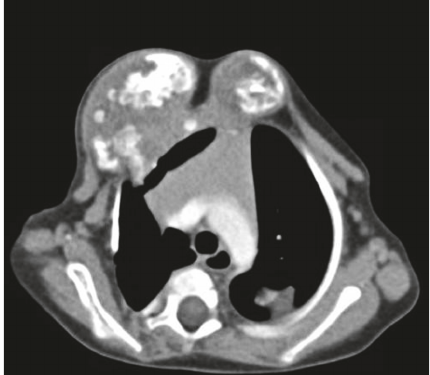
Figure 1: This contrast chest CT scan shows multiple bilateral masses involving mainly the upper ribs, extending into the thorax and causing mediastinal shift to the left. The largest mass measuring 5,7 cm × 4,1cm is located on the right side. The masses consist of large multiloculated soft tissue lesions with calcifications. The appearance is mostly suggestive of a chest wall bone tumor with likely soft tissue